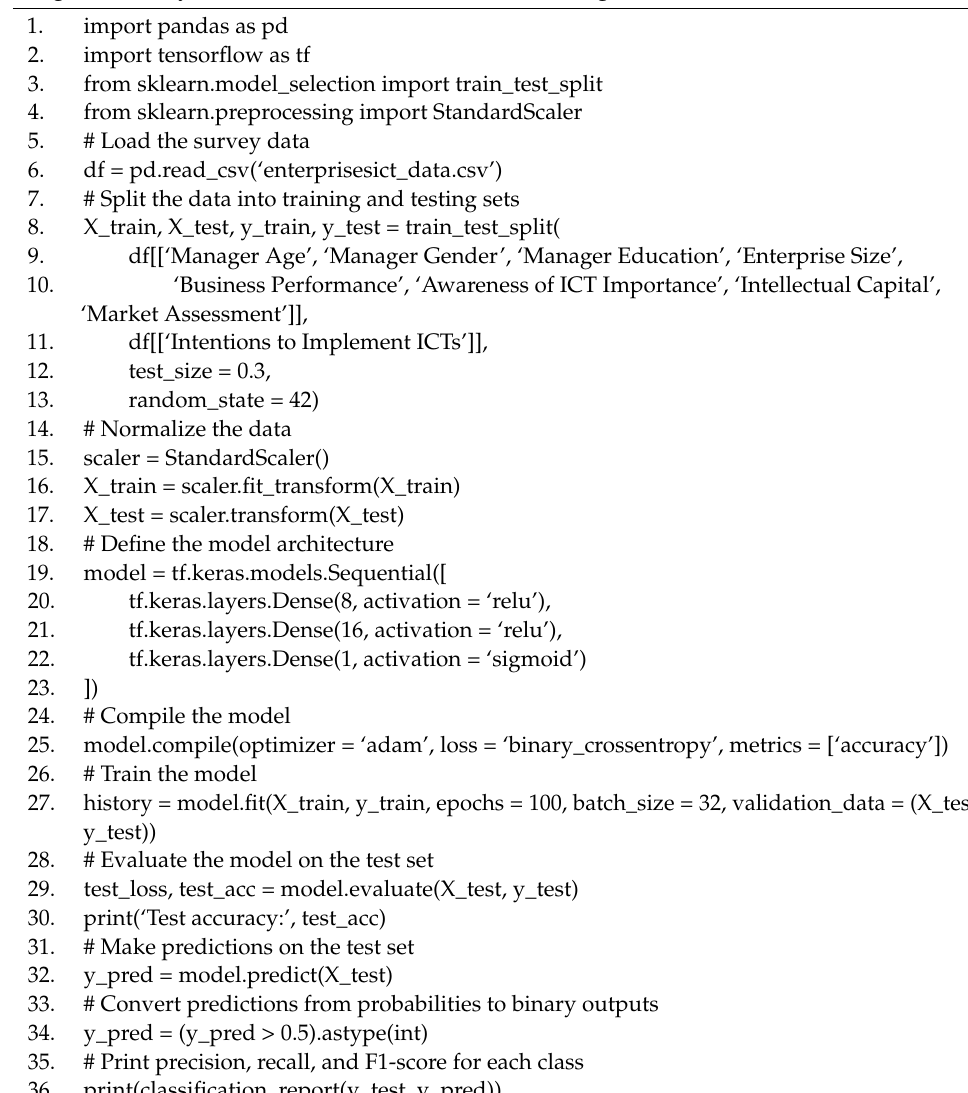
Algorithm 3. Python Cozde for Neural Network Training